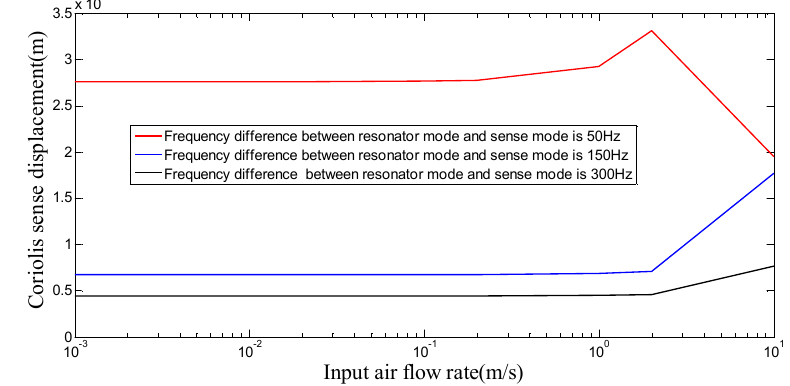
Figure 10. The influence of air flow rate on sense displacement of angular velocity.